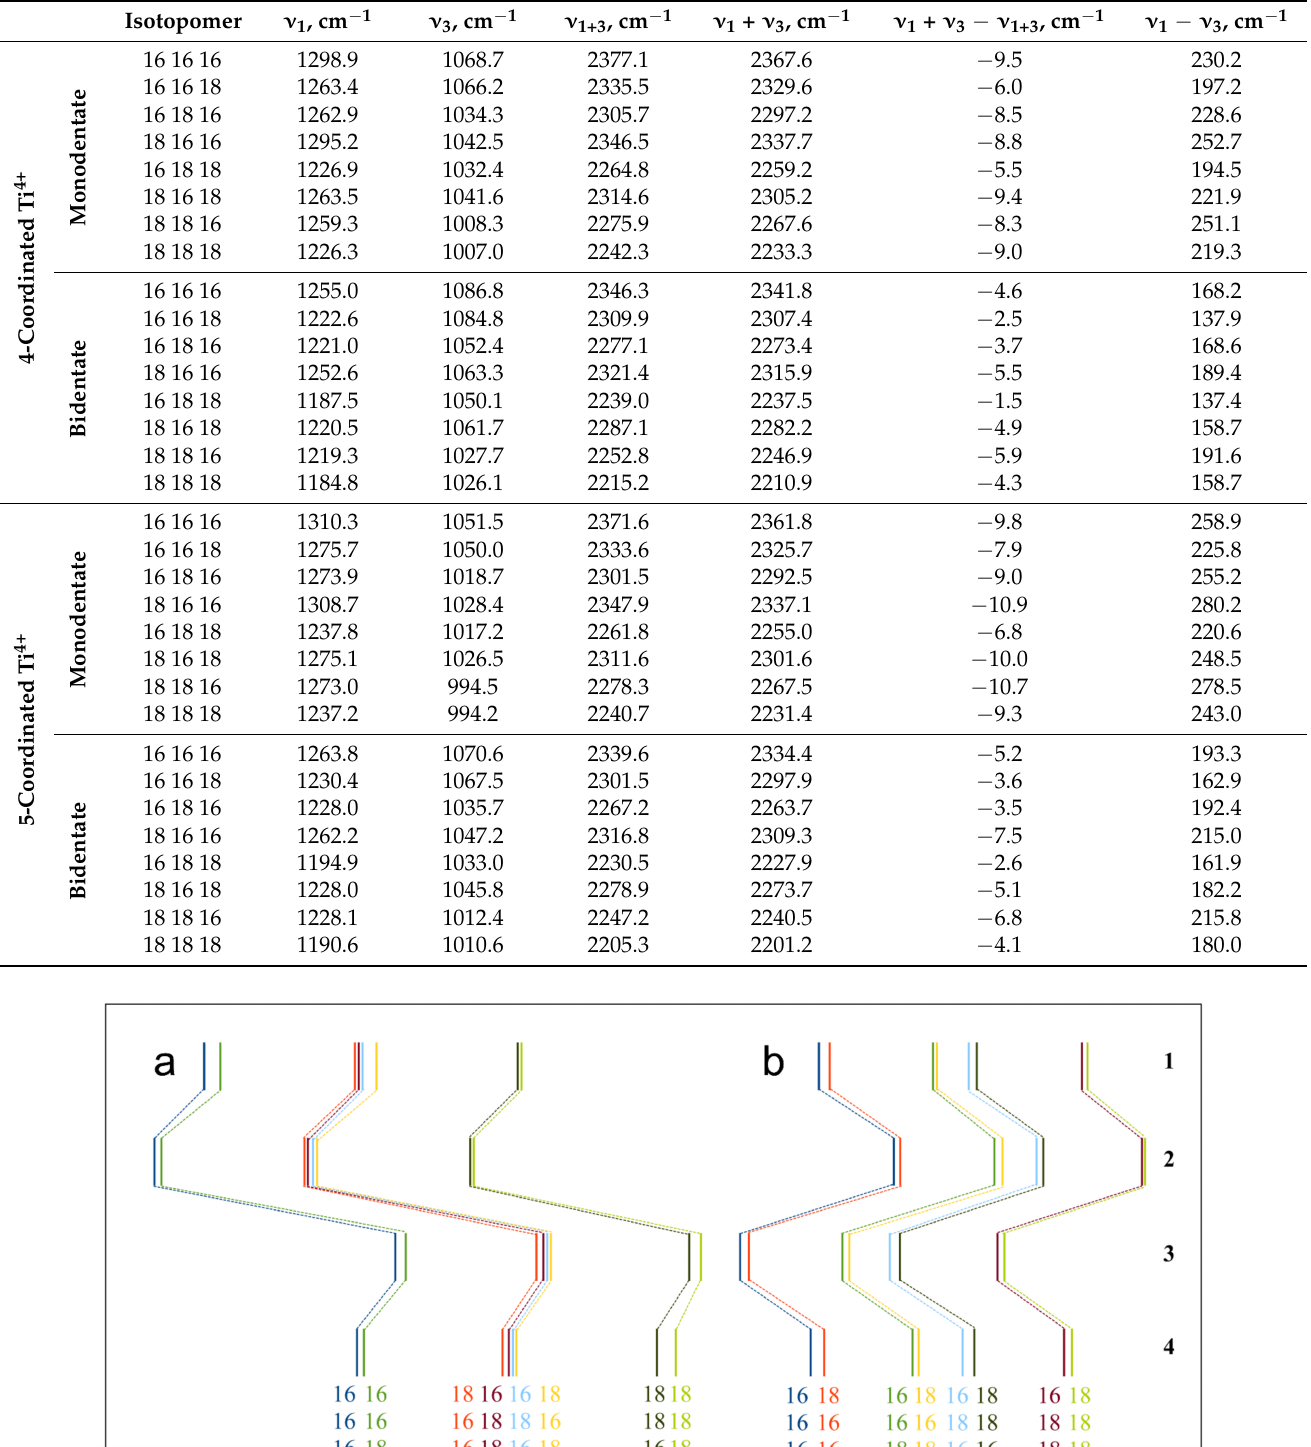
Table 3. Calculated frequencies of ozone isotopomers forming complexes with the relaxed anatase cluster Ti 20 O 40 . Isotopomer